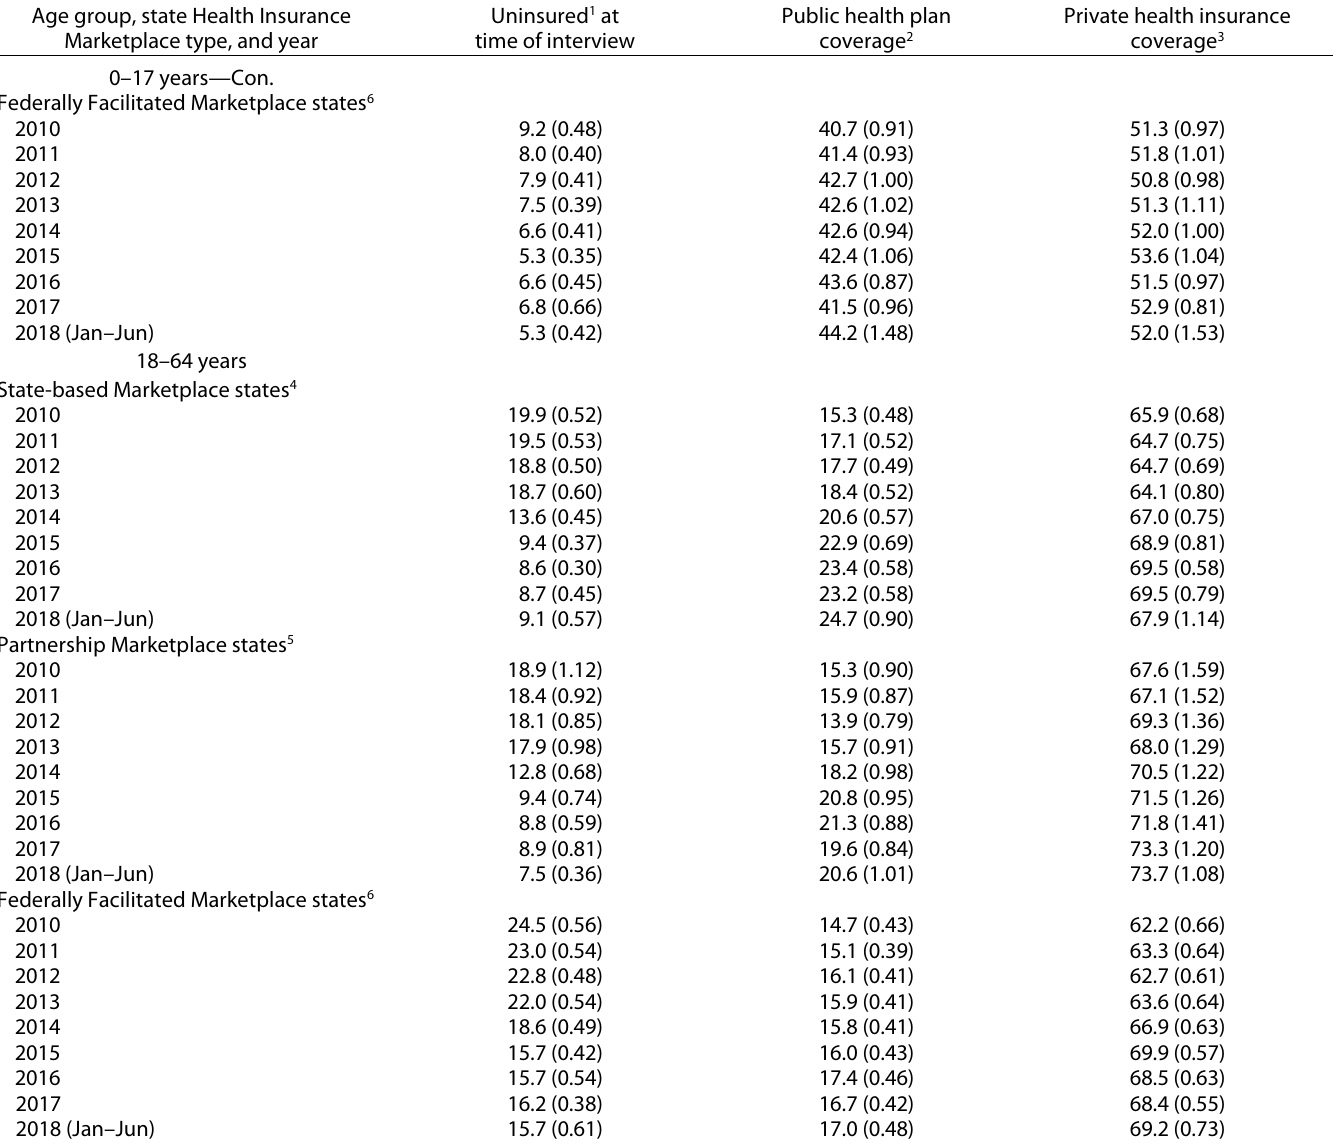
Table XIV. Percentages (and standard errors) of persons under age 65 who lacked health insurance coverage, had public health